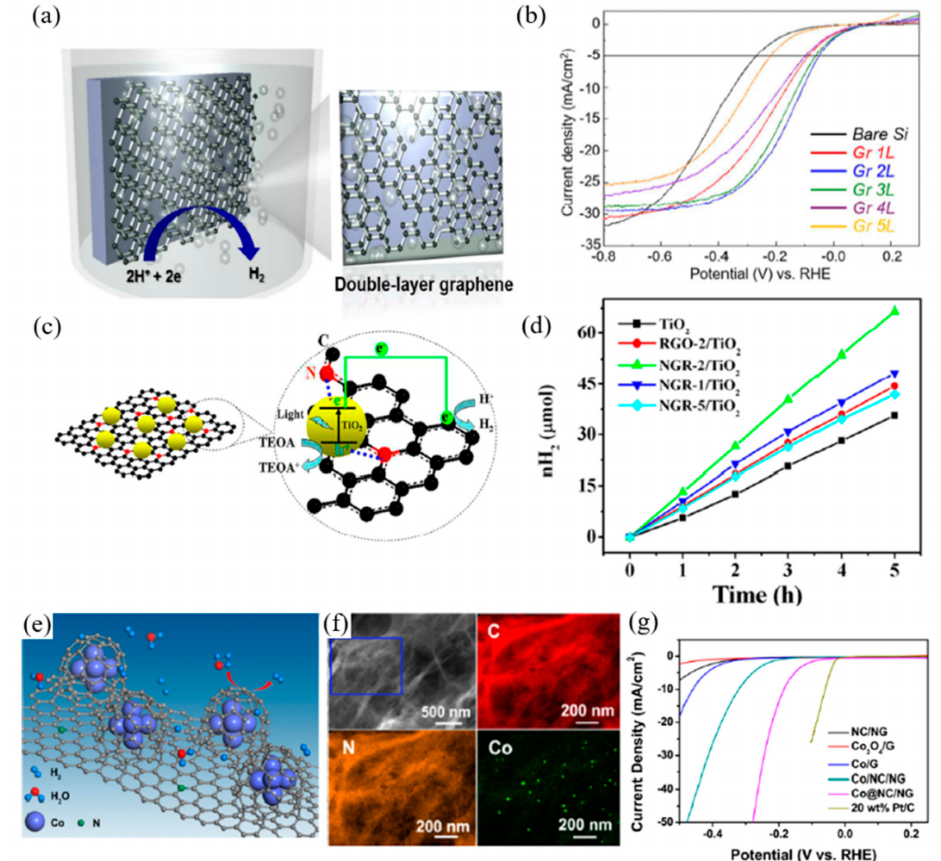
Figure 2. Graphene applied in photoelectrochemical cells ( a , b ), as photocatalysts ( c , d ), and electrochemical cells. ( e – g ) for water splitting reactions. ( a ) Schematic of double-layer graphene on p-silicon photocathode, ( b ) Photocurrent density–potential (J–E) curves of multiple layers of graphene on lightly boron-doped planar p-Si [39], ( c ) Schematic illustration for the strong coupling between TiO 2 and N atoms in N-doped graphene sheets (NGR), enhanced photoinduced charge transfer, and photocatalytic hydrogen generation, ( d ) The time course of hydrogen production from a 50 mL aqueous solution containing 10 vol% TEOA aqueous solution with different photocatalysts [42], ( e ) Schematic representation of the HER process at the surface Co / NGR, ( f ) EDS elemental maps of C, N, and Co for Co / NGR, ( g ) Polarization curves for HER in 0.5M H 2 SO 4 at a glassy carbon electrode modified with indicated catalysts